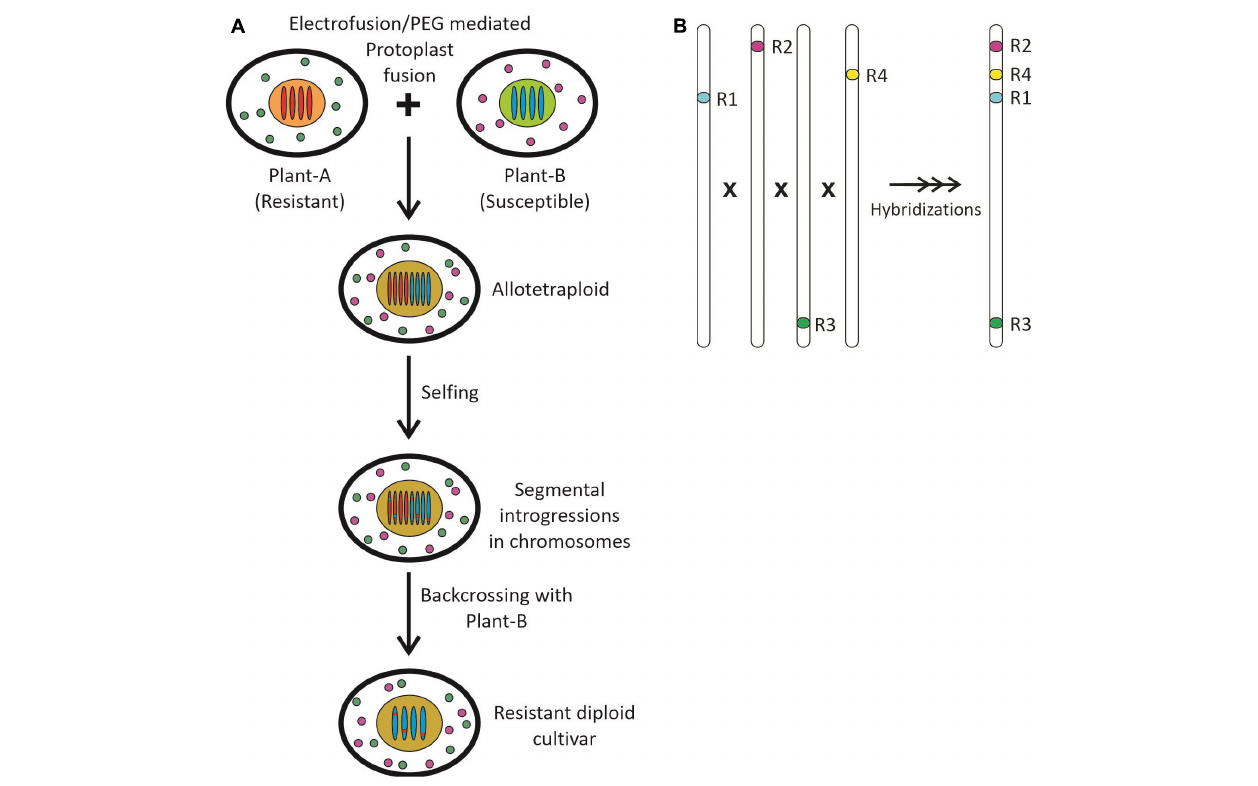
FIGURE 2 | (A) The development of resistant segmental introgression lines from susceptible cultivars through PEG mediated protoplast fusion and subsequent backcrossing; (B) The gene pyramiding approach by wide hybridization and selection.